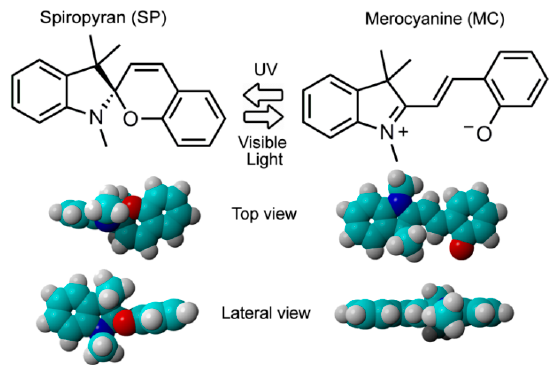
Scheme 1. Basic equilibrium between the spiropyran and merocyanine species of a non-substituted